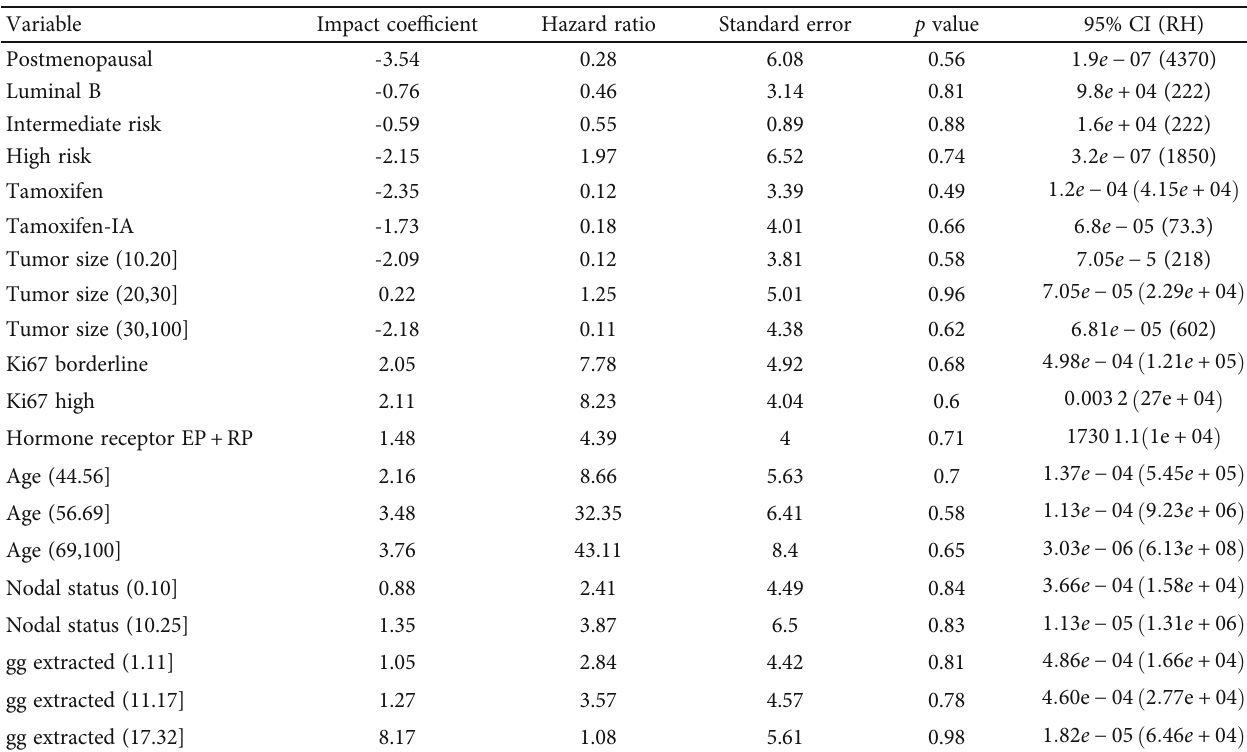
Table 11: Impact index, standard error, risk index, p value, and 95% con fi dence intervals using the Cox model as a whole Hospital. Variable